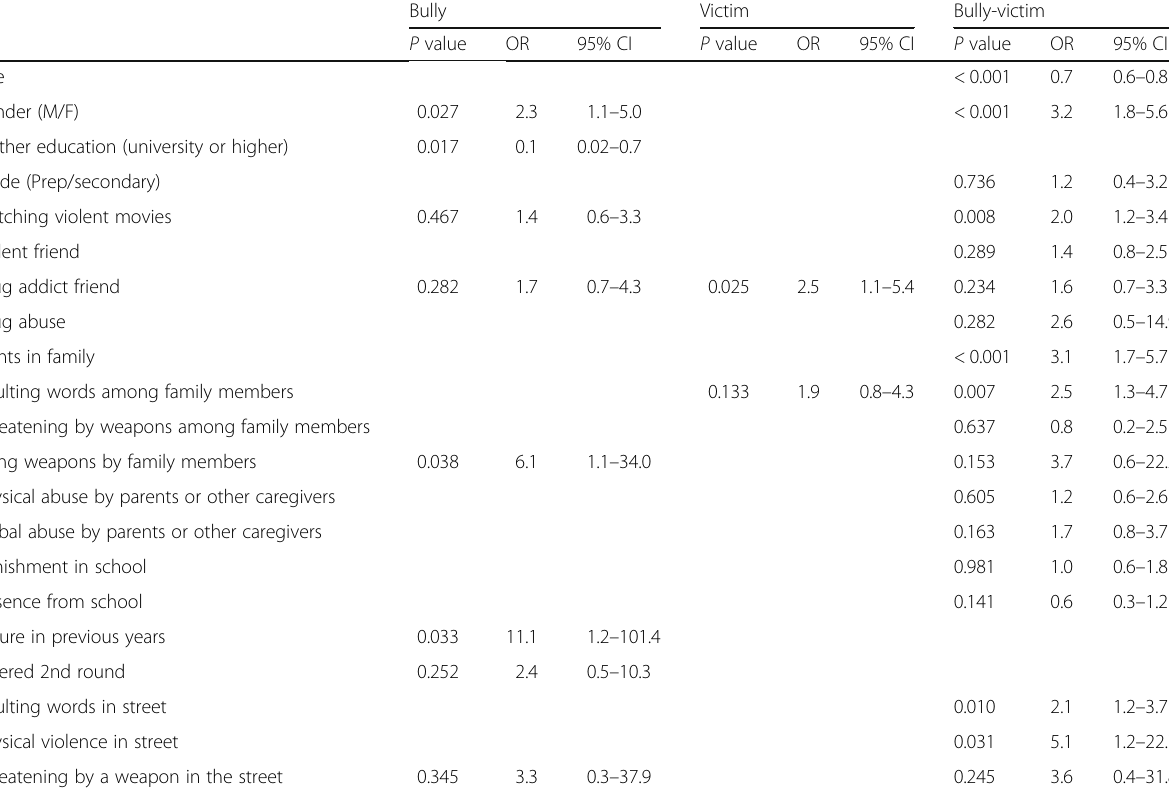
Table 4 Logistic regression model of factors associated with bullying behavior among the studied group Bully Victim